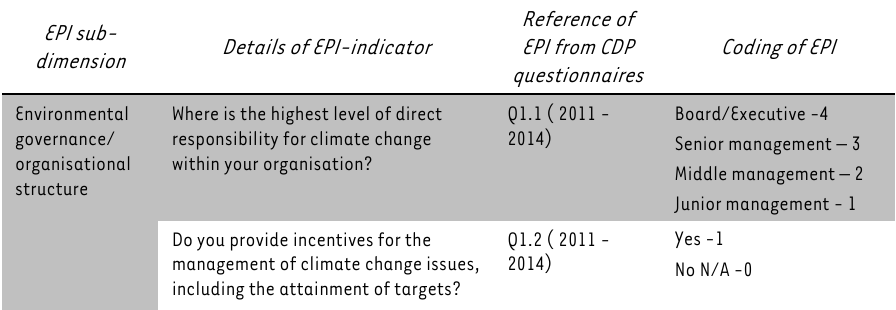
TABLE 3: Bank EMP scoring index EPI sub-